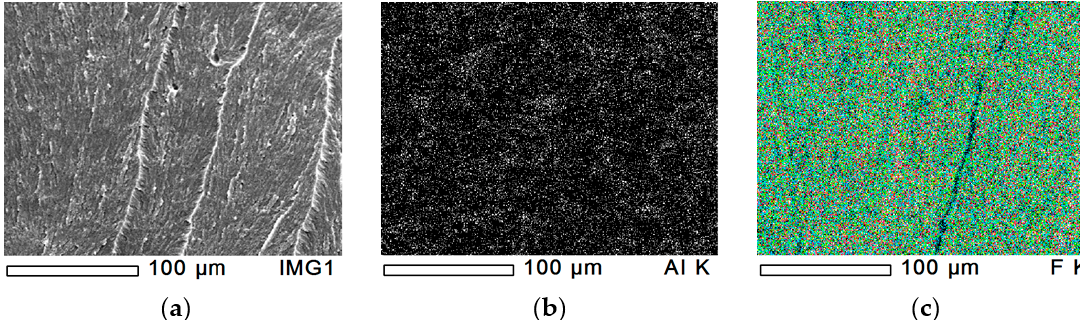
Figure 4. EDS analysis of PTFE / BA80-4 sample with 500 × magnification. ( a ): original cryo-fractured Figure 4. EDS analysis of PTFE/BA80-4 sample with 500× magnification. ( a ): original cryo-fractured surface, ( b ): aluminium content and ( c ): fluorine surface, ( b ): aluminium content and ( c ): fluorine content. Figure 4. EDS analysis of PTFE/BA80-4 sample with 500× magnification. ( a ): original cryo-fractured surface, ( b ): aluminium content and ( c ): fluorine content. Figure 4. EDS analysis of PTFE/BA80-4 sample with 500× magnification. ( a ): original cryo-fractured surface, ( b ): aluminium content and ( c ): fluorine content.